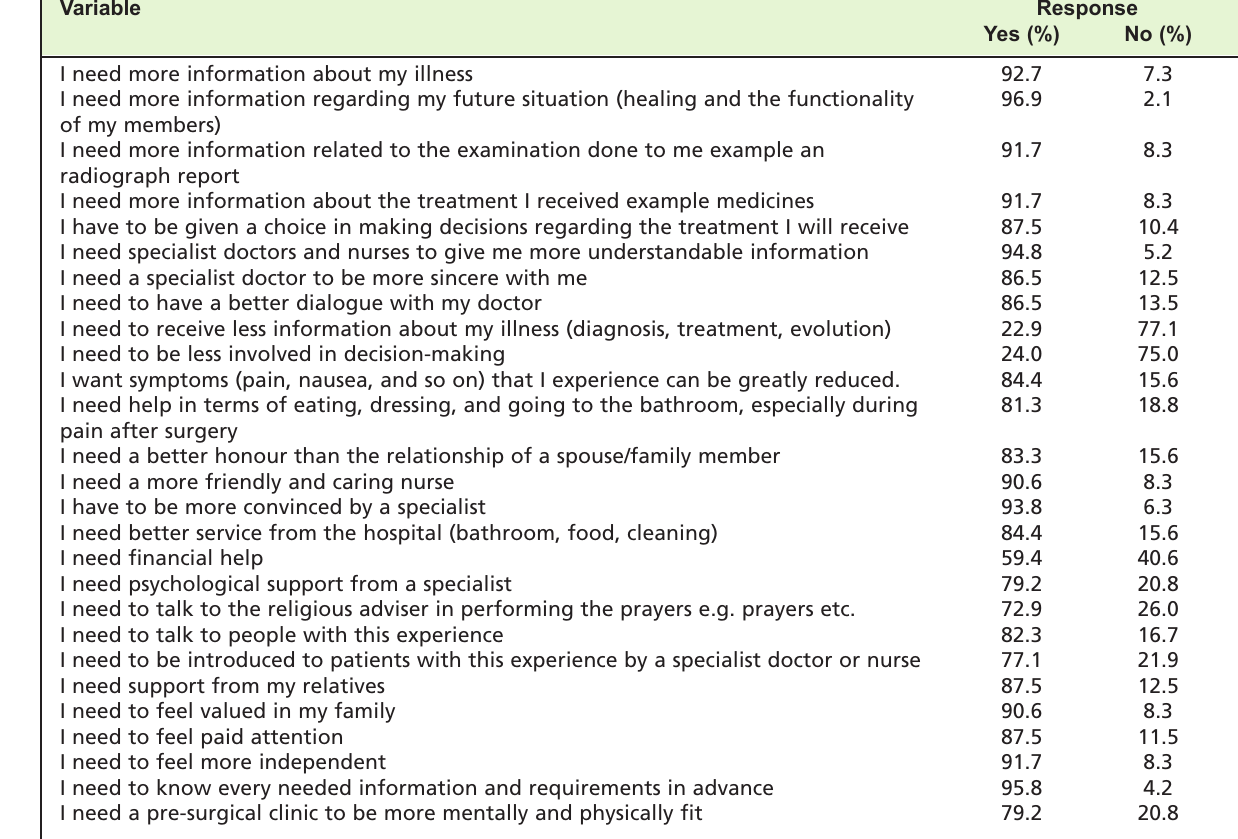
Table IV: The responses for patients' needs evaluation (n=96).